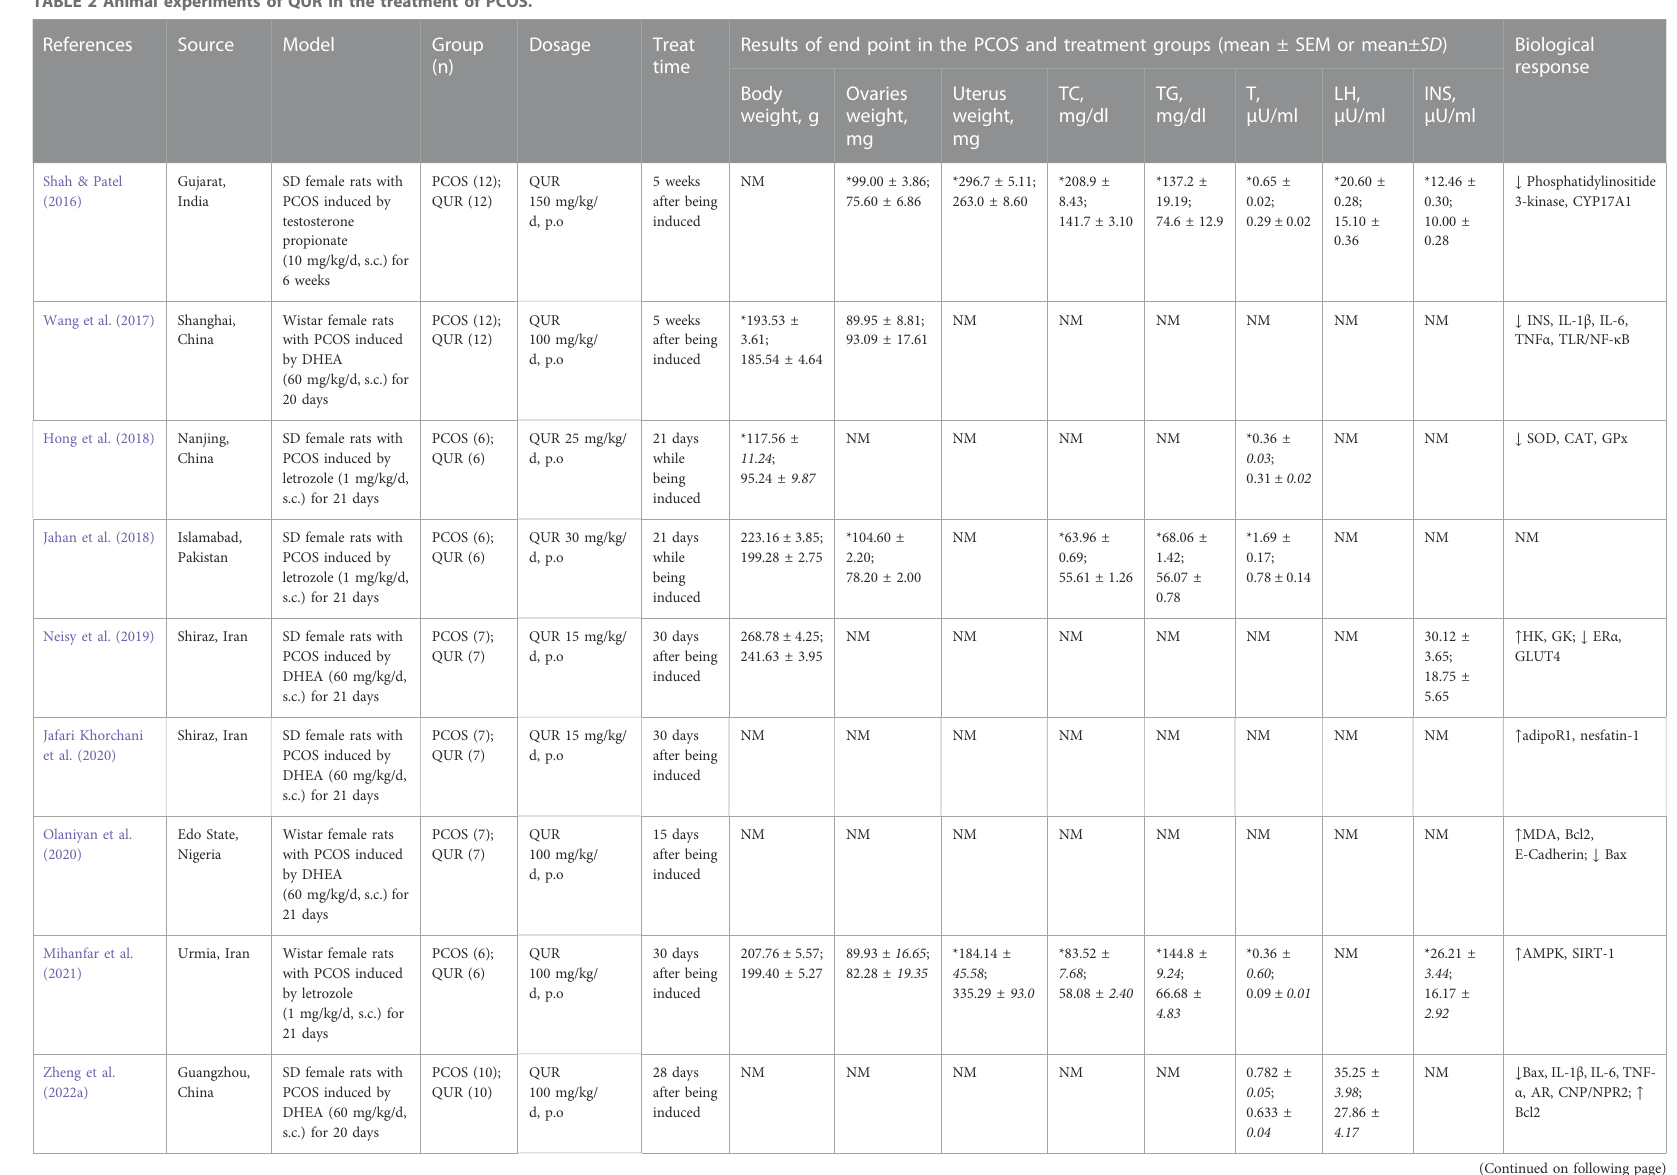
TABLE 2 Animal experiments of QUR in the treatment of